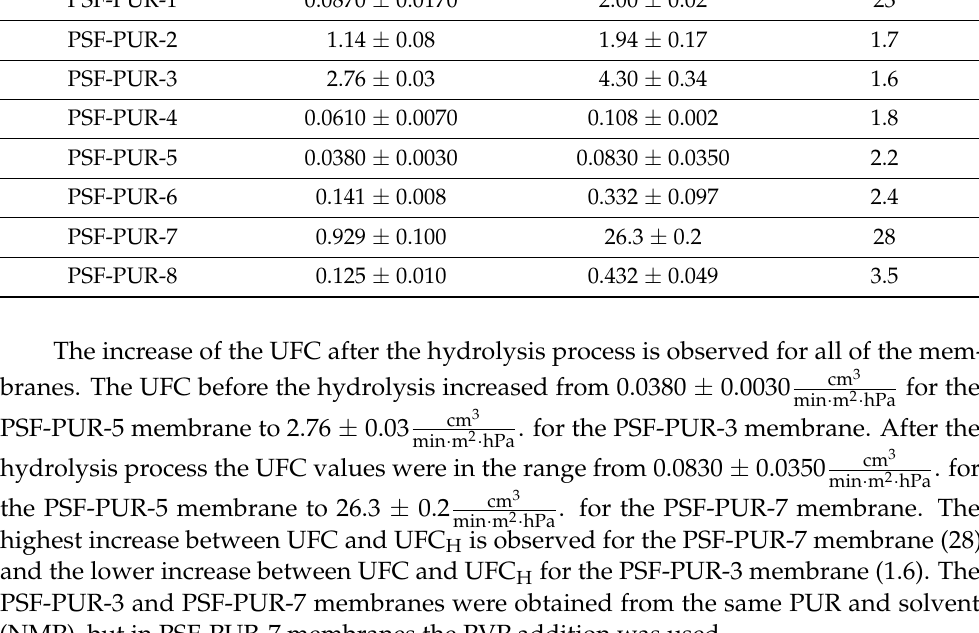
(cid:104) (cid:105) cm 3 UFC H min · m 2 · hPa